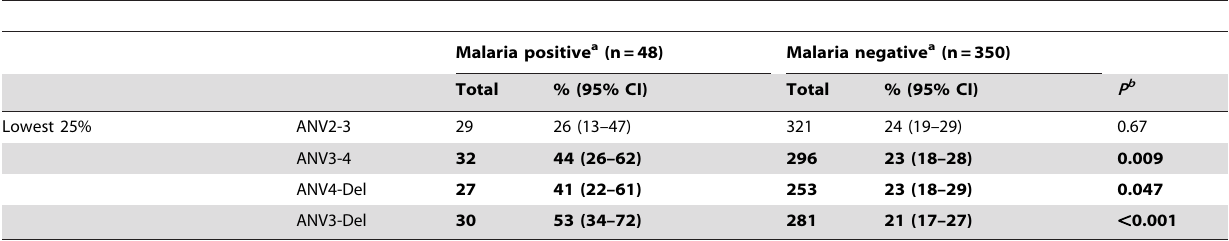
Table 4. Proportion of primi and secundigravidae with a fetal weight gain belonging to the lowest 25%, stratified by malaria positivity.